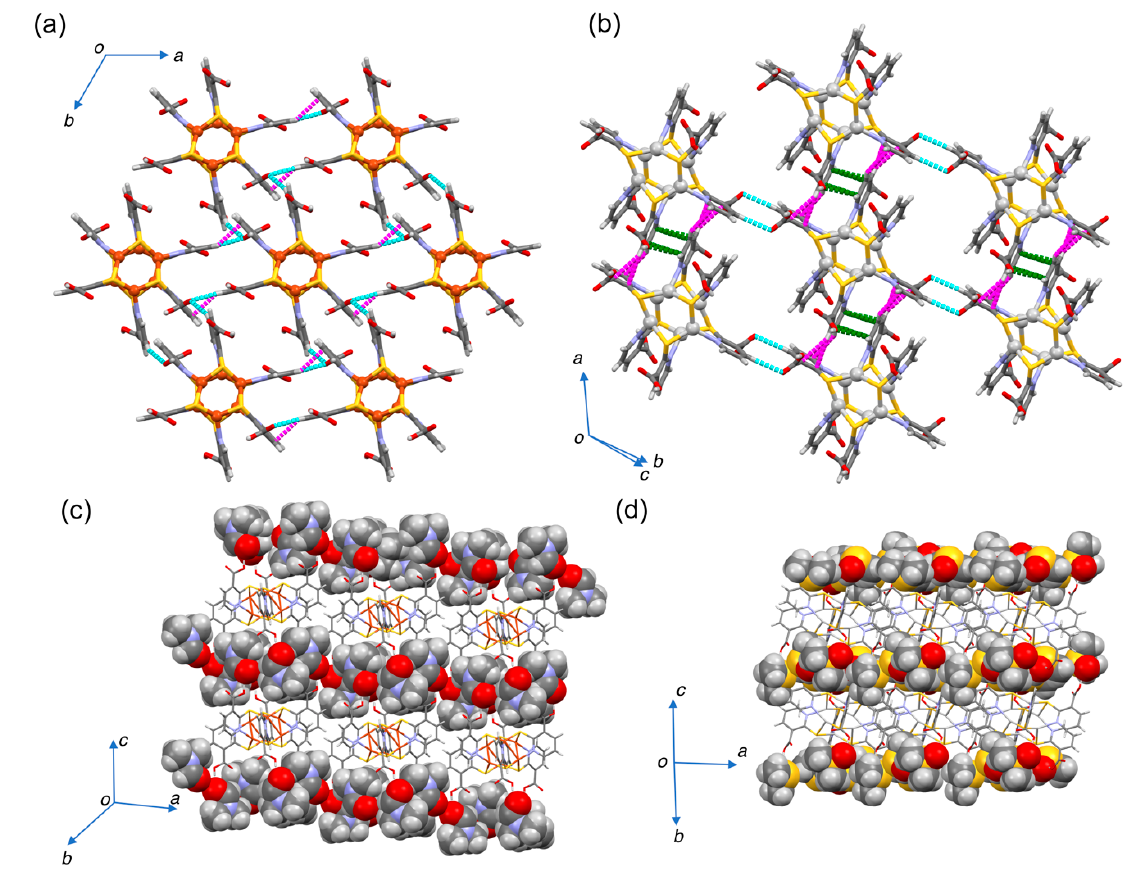
Figure 4. Crystal packing diagrams of ( a ) 1 ·7DMF viewed along the c -axis and ( b ) 2 ·8DMSO viewed along the [0 − 1 1] direction. Solvent guests were omitted for clarity. Intermolecular CH···O H-bonds, CH··· π interactions , and π ··· π stacks are represented as cyan, magenta, and green broken lines, respectively. Alternate lamellar stacking in ( c ) 1 ·7DMF and ( d ) 2 ·8DMSO comprising of the paddlewheel layer (shown as a stick model) and the solvent–guest layer (shown as a space-fill model). Color codes: Cu, brown; Ag, light gray; S, yellow; O, red; N, blue; C, gray; H, pale gray.